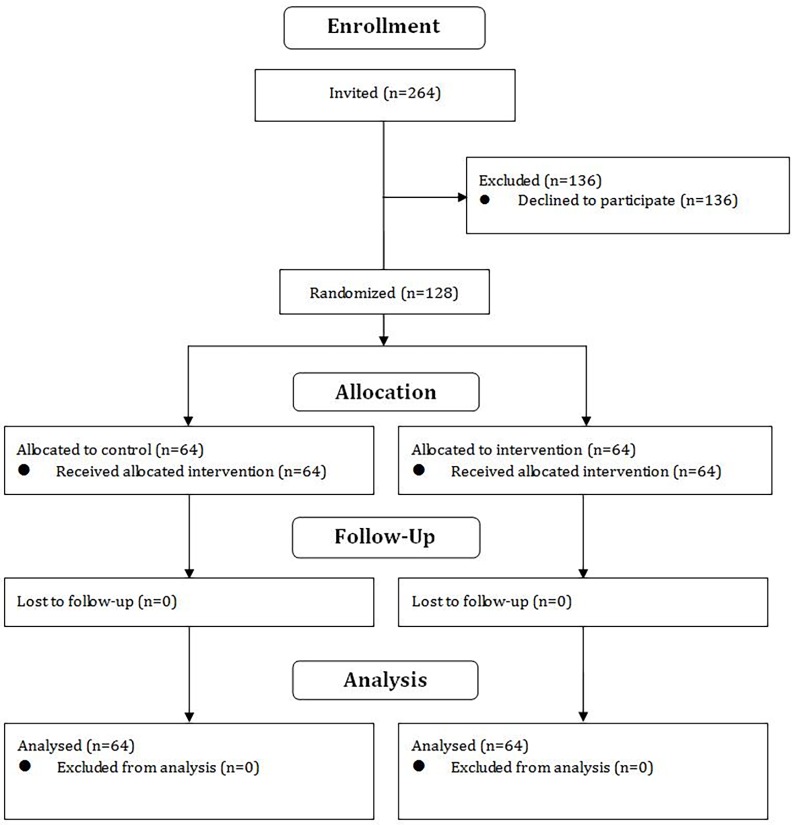
CONSORT diagram.